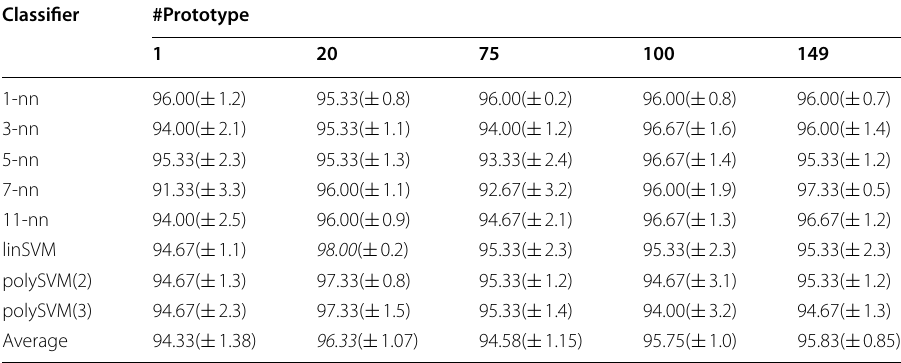
Table 3 Evaluation of proposed method on Iris dataset in terms of accuracy (%) with tenfold cross validation (best results denote in italics typeface)